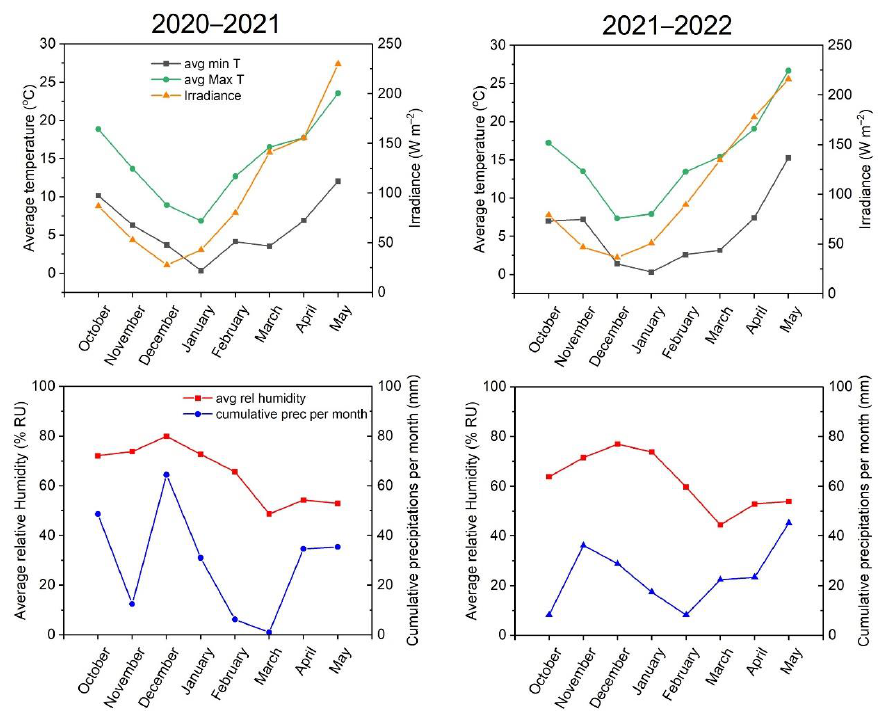
Figure A1. Meteorological data derived from the Meteorological Observatory of the Botanical Garden of Ferrara, Italy, relative to the two experimental cultivation seasons (2020 – 2021 and 2021 – 2022).